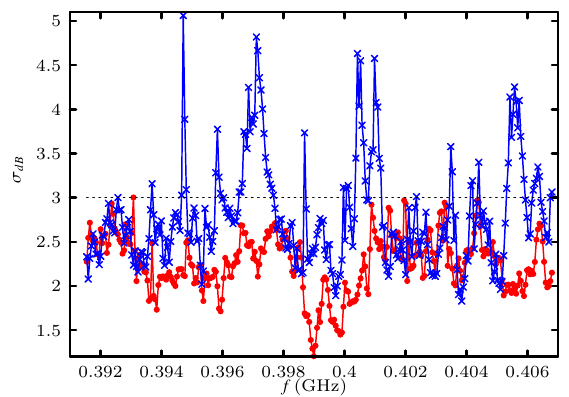
Figure 4: Fluctuations of maxima in dB. Chaotic RC: red connected points. Conventional RC: blue connected